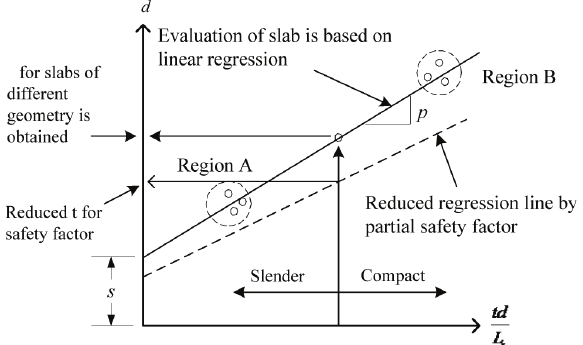
Fig. 4. Determination of the ultimate shear bond strength for the use in the PSC